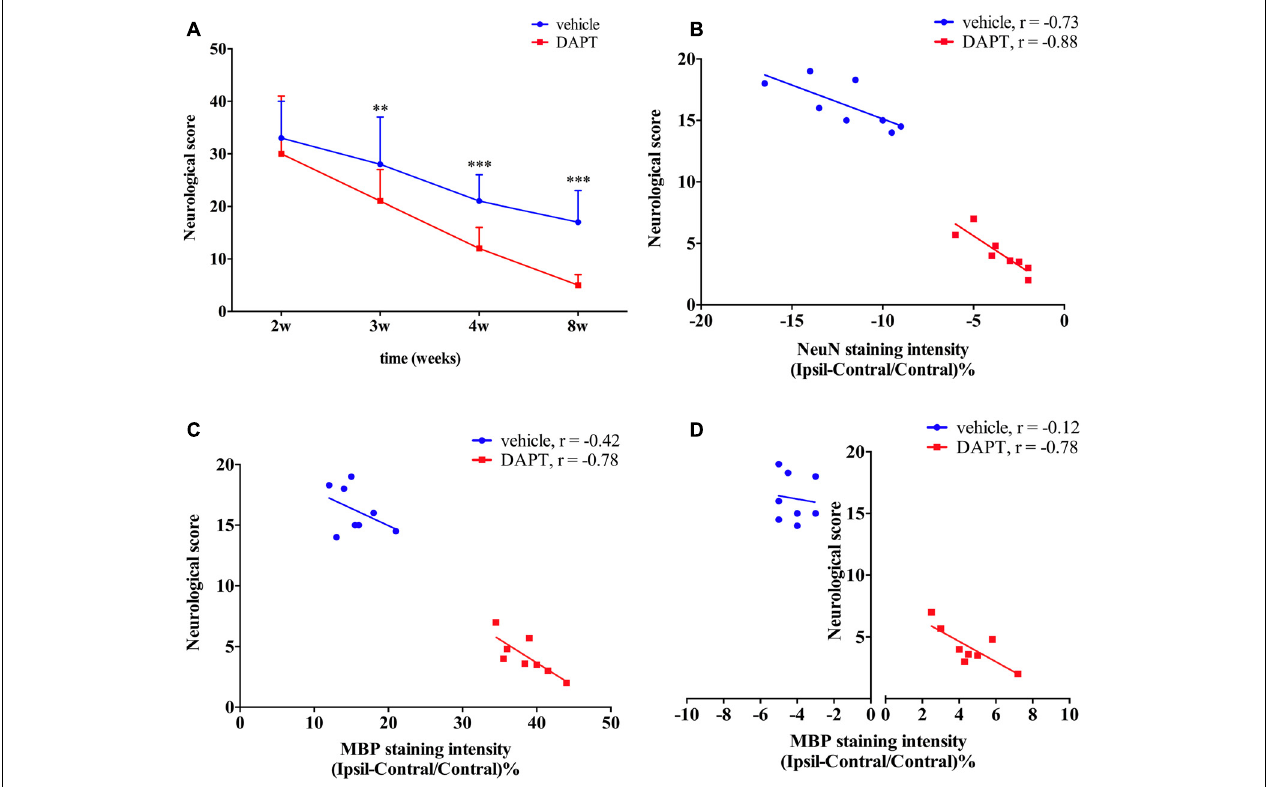
FIGURE 11 | Functional test and correlation analysis. (A) Neurological score. (B) The correlation analyze between neurological score and NeuN staining intensity. (C) The correlation analyze between neurological score and MBP staining intensity of ipsilateral STR. (D) The correlation analyze between neurological score and MBP staining intensity of ipsilateral